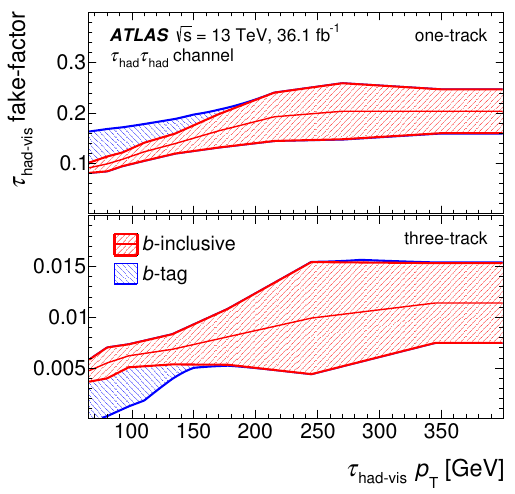
Figure 2. The (cid:28) had-vis identi(cid:12)cation fake-factors in the (cid:28) had (cid:28) had channel. The red band indicates the total uncertainty when used with a b -inclusive or b -veto selection. The blue band indicates the additional uncertainty when used with a b -tag